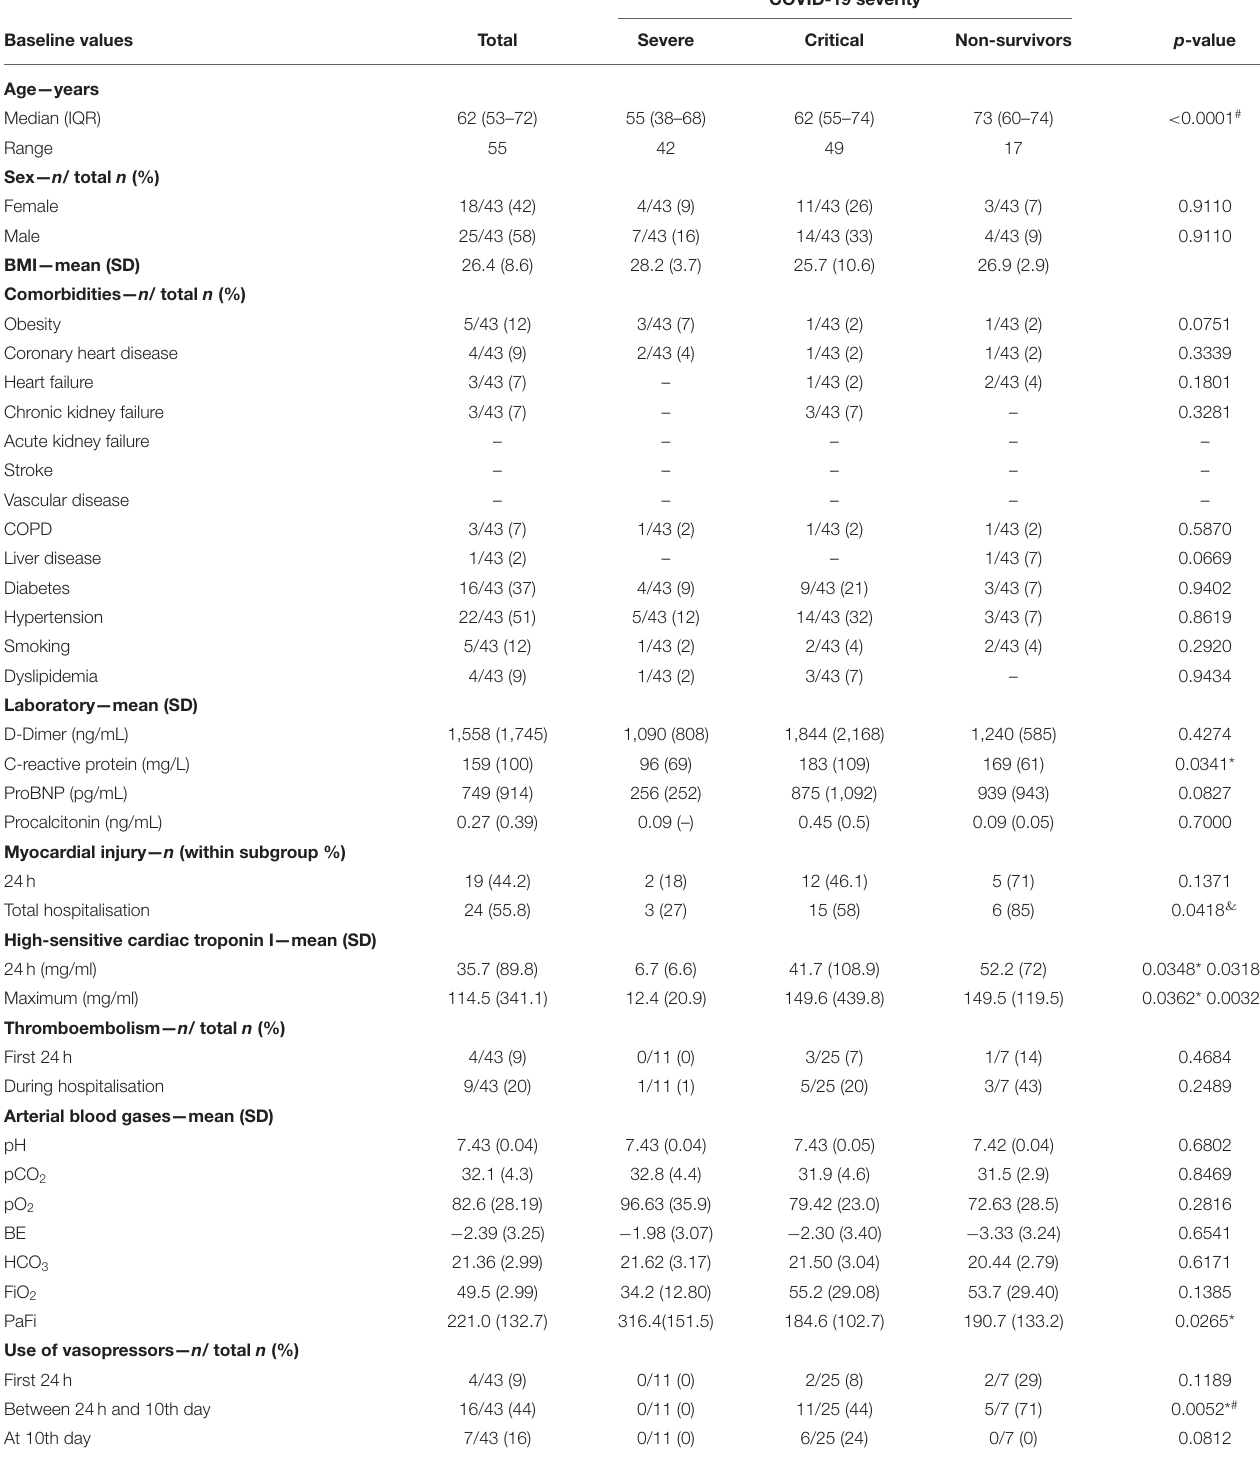
TABLE 1 | Patients